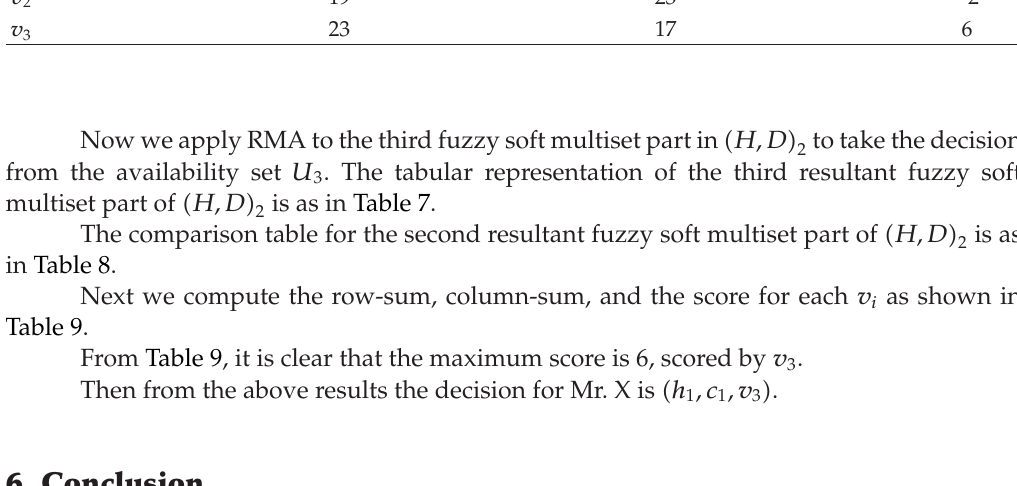
(cid:5) H,D (cid:6) . 2 − 2 − 2